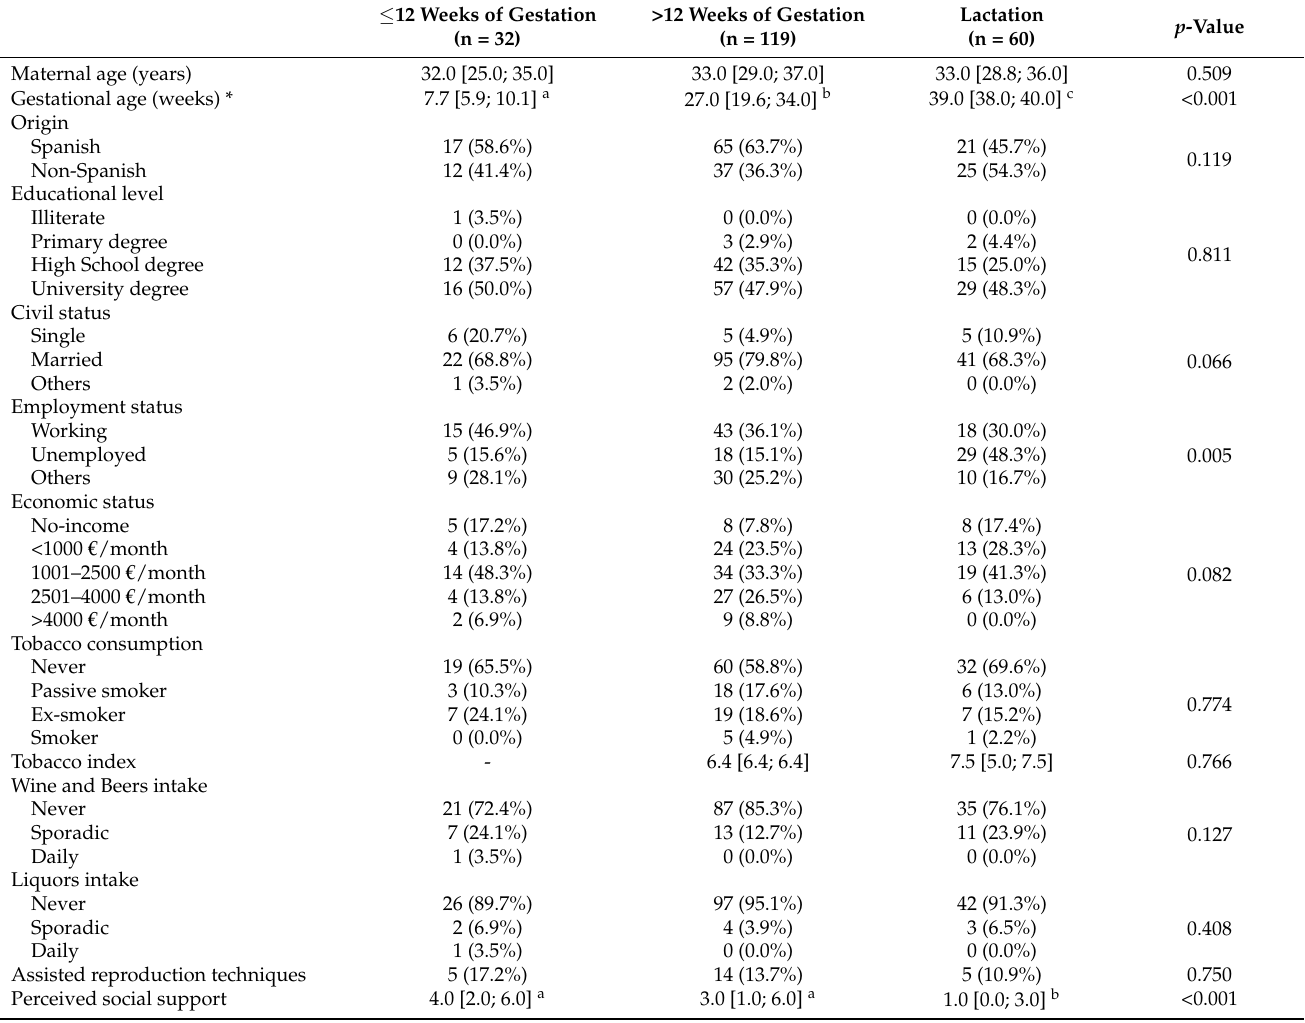
Table 1. Differences in sociodemographic characteristics between groups.